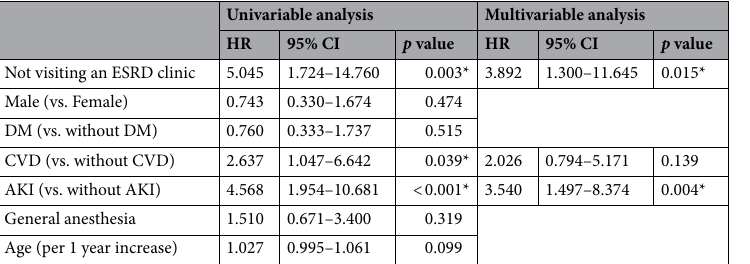
Table 2. Analysis of the relationship between not visiting an ESRD clinic and mortality rate (A in Fig. 3). HR, hazard ratio; CI, confidence interval; ESRD, end-stage renal disease; DM diabetes mellitus; CVD, cardiovascular disease; AKI, acute kidney injury. * p value < 0.05.